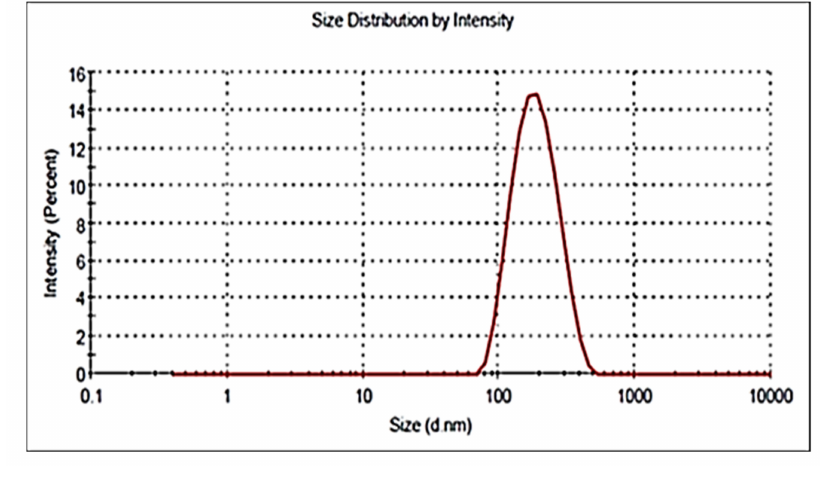
Figure 5. Particle size image of ON2.